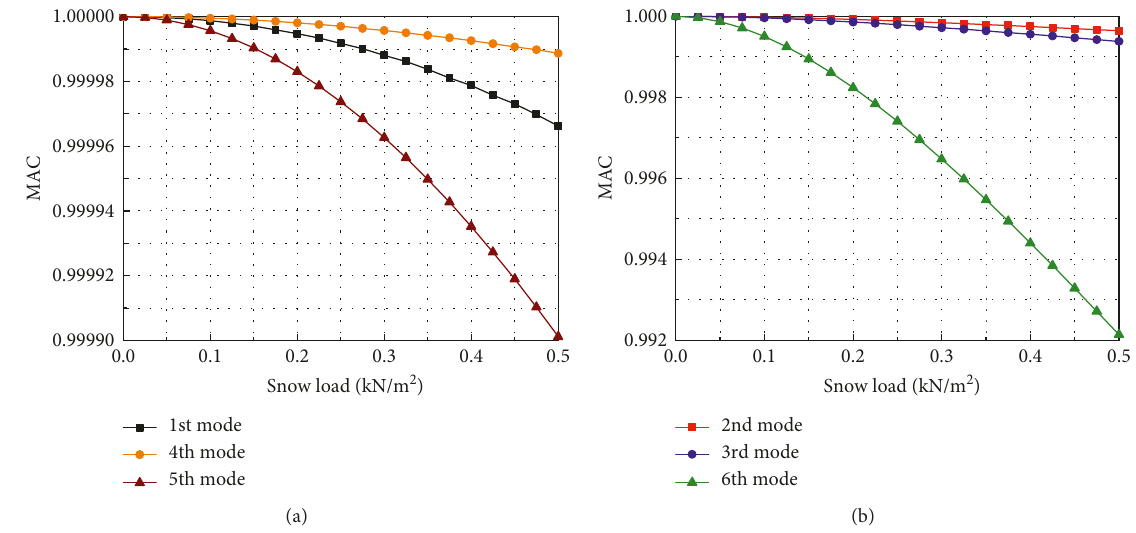
Figure 24: MAC values of the mode shapes on vertical direction under uniformly distributed snow load: (a) the 1st, 4th, and 5th modes and (b) the 2nd, 3rd, and 6th